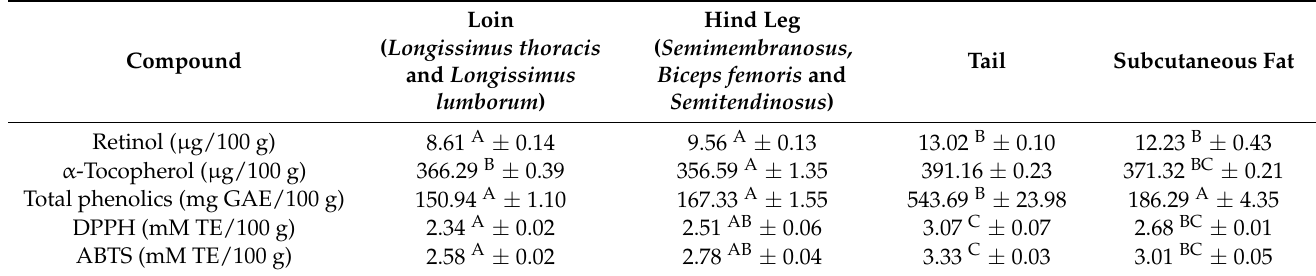
Table 2. Concentration of retinol, α -tocopherol, and antioxidant activity of beaver tissues (mean and standard